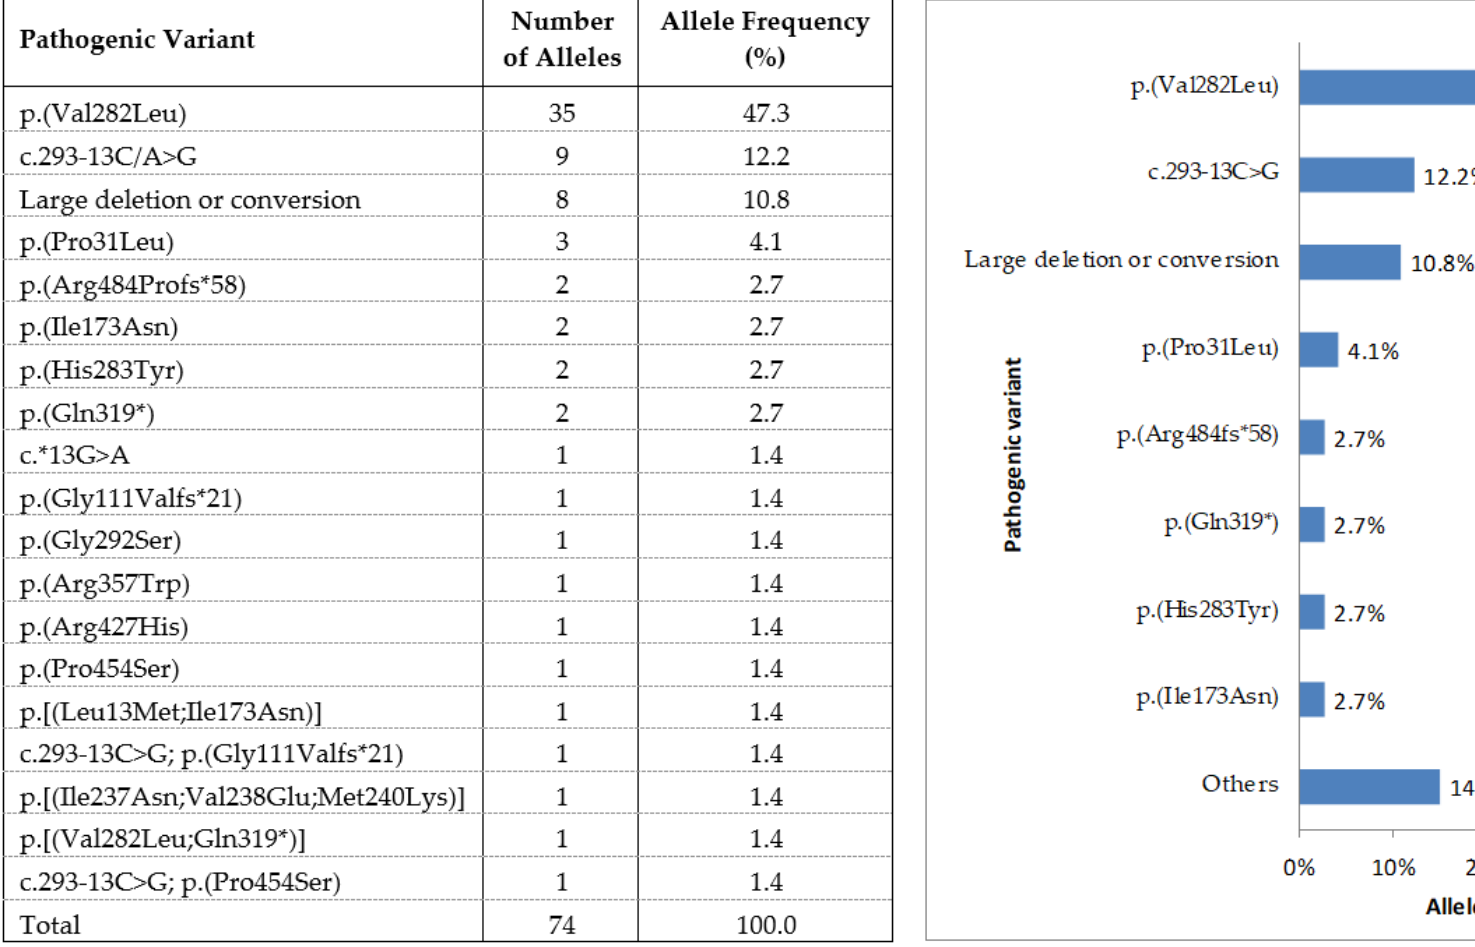
Panel 1. Mutation frequency of the 74 affected alleles from 37 unrelated patients with 21-hydroxylase enzyme (21-OH).